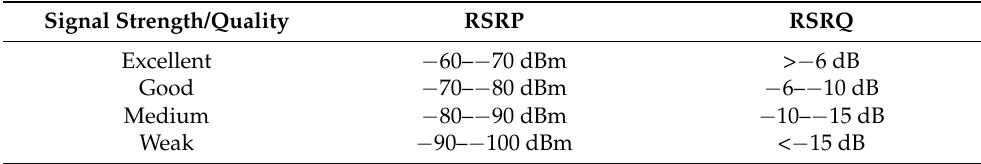
Table 6. Signal status based on RSRP and RSRQ values [56]. Signal